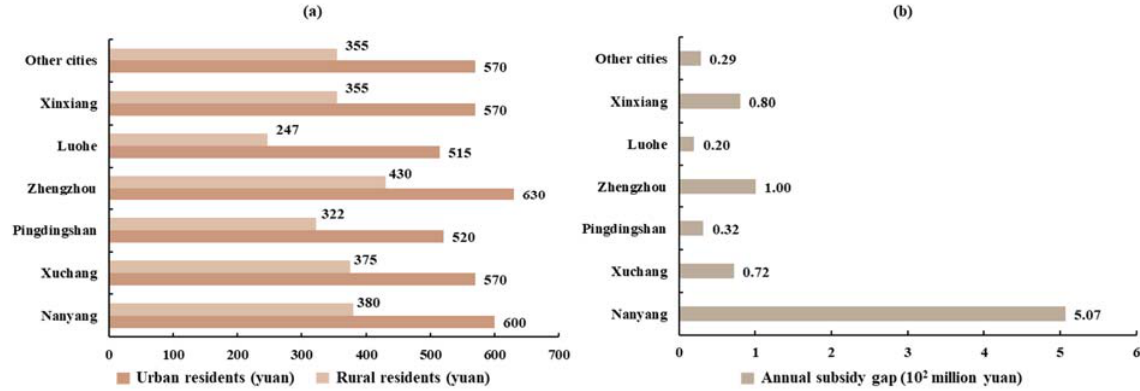
Figure 12. Subsidy of each city. ( a ) Minimum standard of living for urban-rural residents and ( b ) subsequent annual subsidy gap